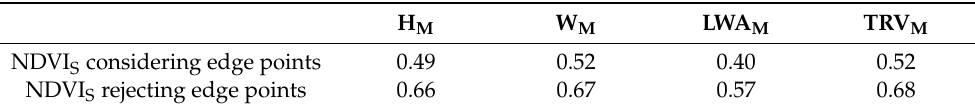
Table 5. Spearman’s rho values for variables obtained using satellite imagery considering and rejecting edge points.